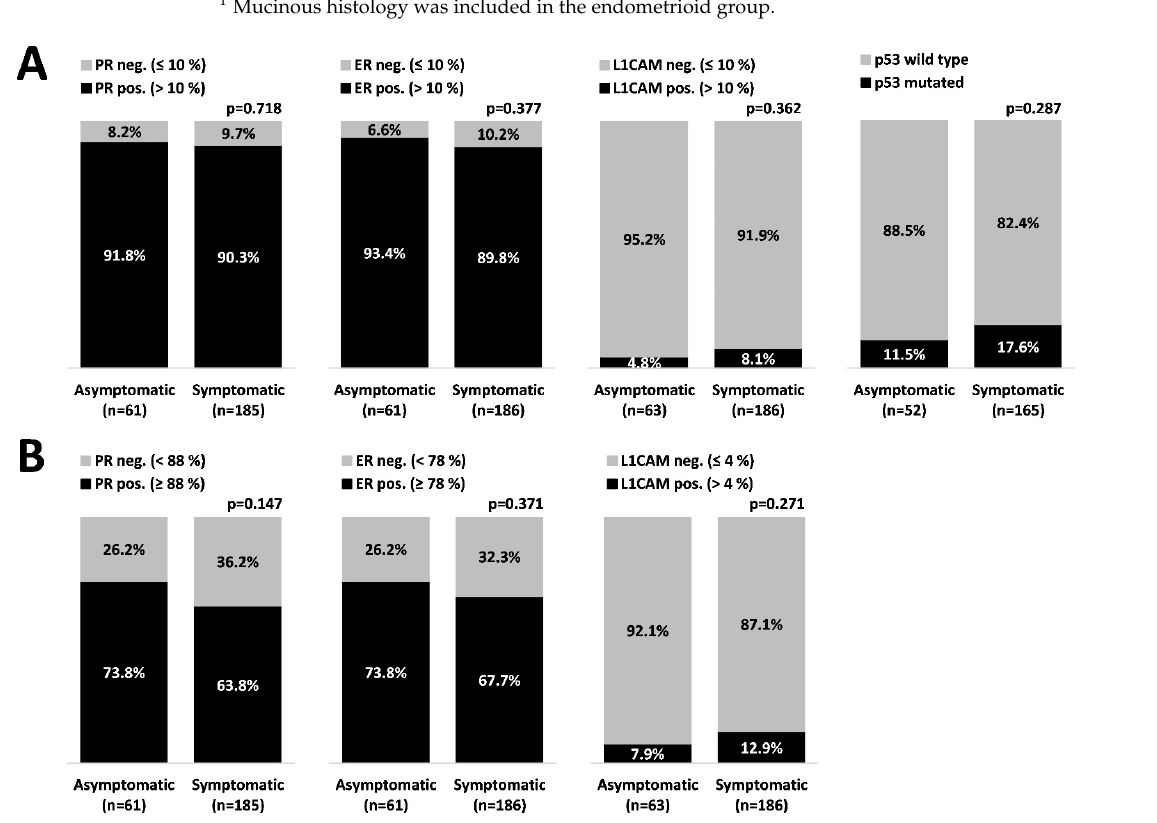
Figure 2. Tumor immunohistochemical profile. ( A ) A standard cut-off [11,14]; ( B ) an alternative cut-off [12].